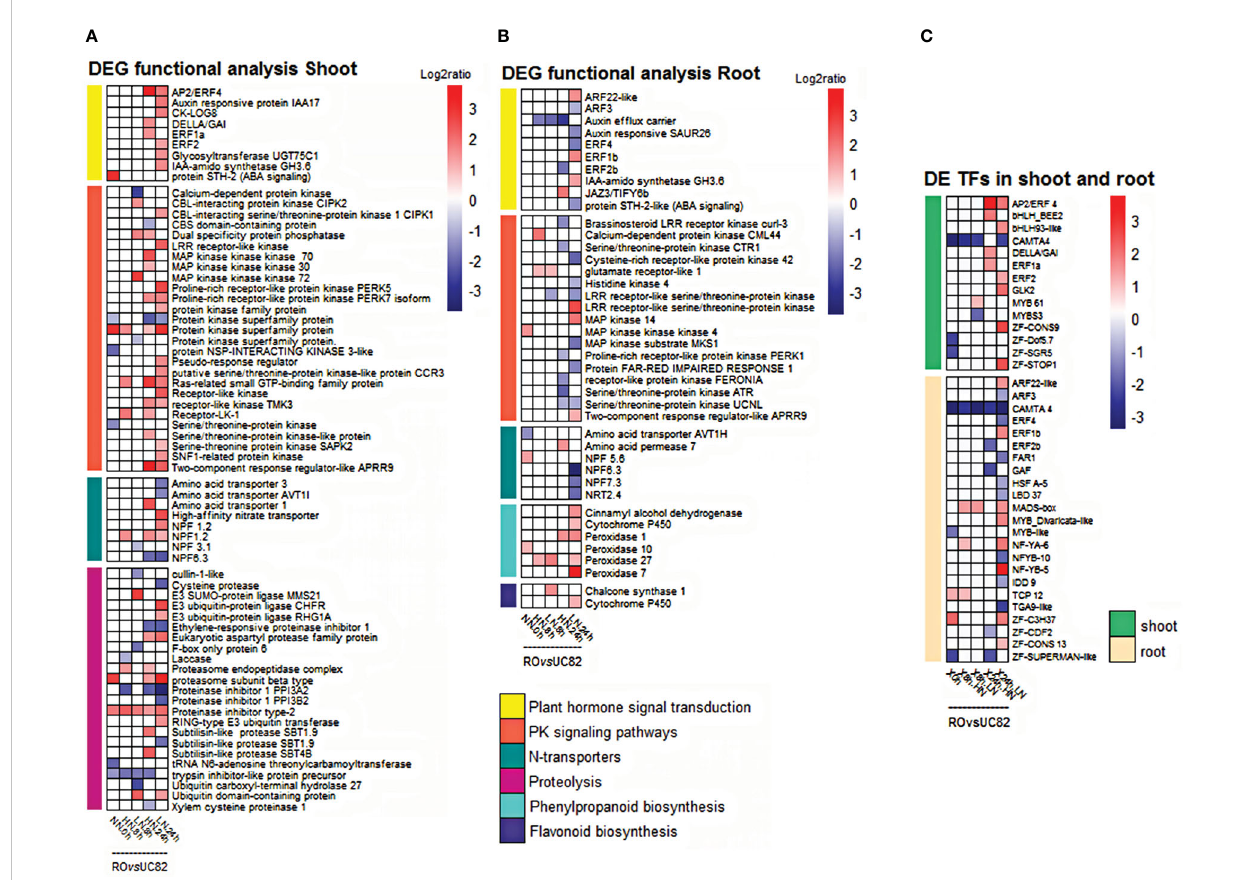
FIGURE 3 Expression level of DEGs included in functional classes based on GO term and KEGG pathway enrichment analyses in both tissues. Heatmap of DEGs involved in signal transduction, protein kinases signaling, N-transport, proteolysis, phenylpropanoid, and fl avonoid biosynthesis in shoot (A) and root (B) , and the differentially expressed TFs in shoot and root (C) in the RO vs . UC82 comparison at 0, 8, and 24 h after low (LN) and high (HN) nitrate